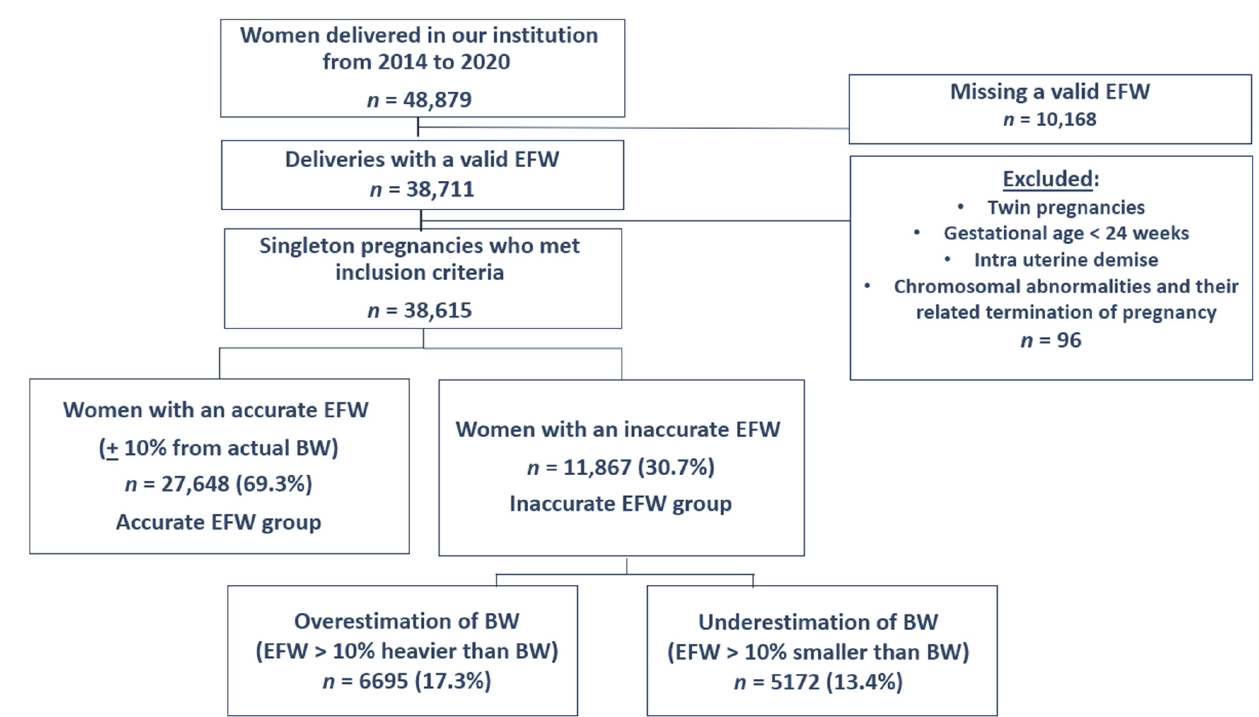
Figure 1. Flowchart describing the study population.